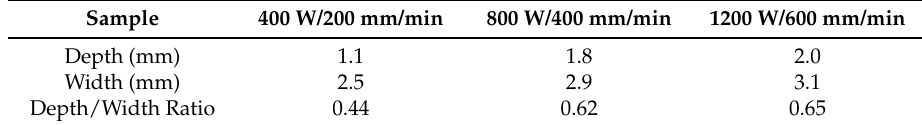
Table 2. Depth-to-width ratio of TL in FA/ZrO 2 specimens prepared using different laser